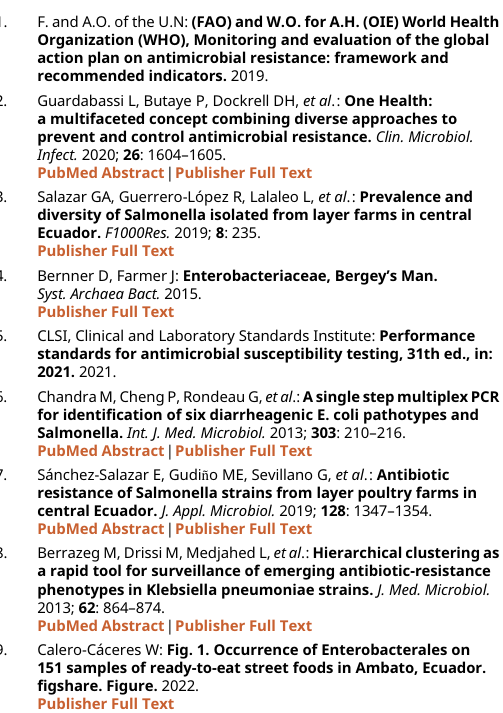
figshare. Figure. 2022. Publisher Full Text